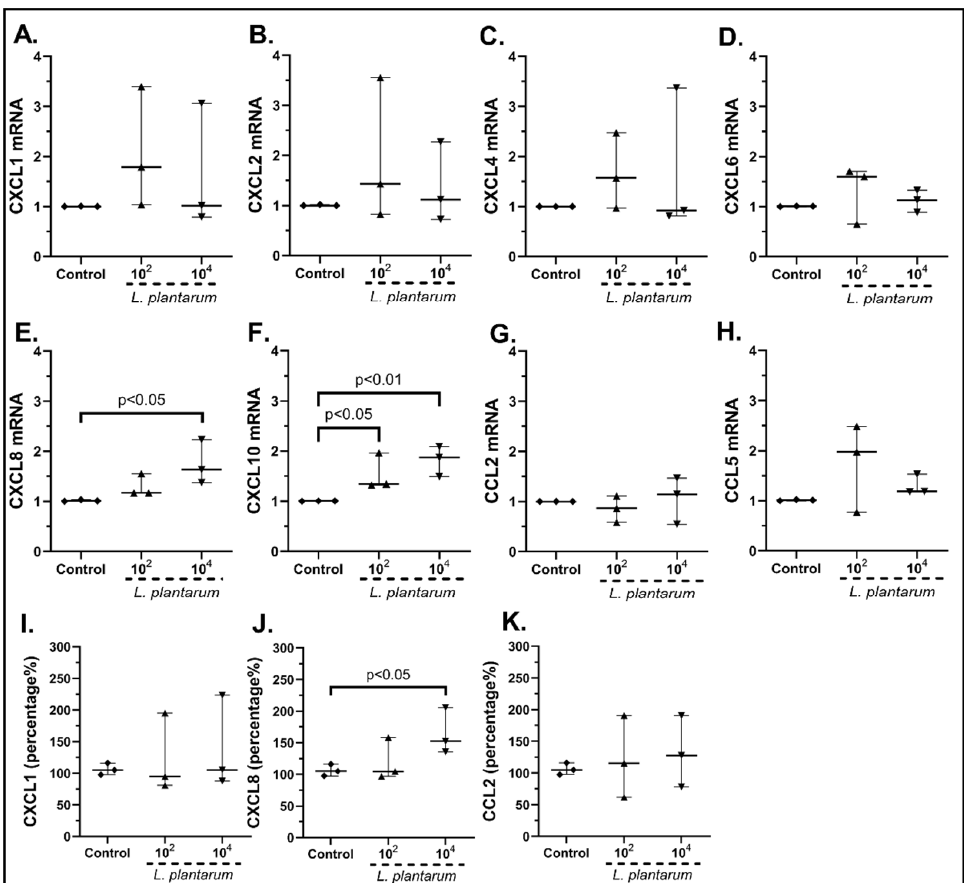
Figure 3. cSEMFs mRNA expression of CXCL1 ( A ), CXCL2 ( B ), CXCL4 ( C ), CXCL6 ( D ), CXCL8 ( E ), CXCL10 ( F ), CCL2 ( G ) and CCL5 ( H ) and protein levels of CXCL1 ( I ), CXCL8 ( J ) and CCL2 ( K ) after stimulation with Lactiplantibacillus plantarum. Results are presented as median with interquartile range. N = 3.